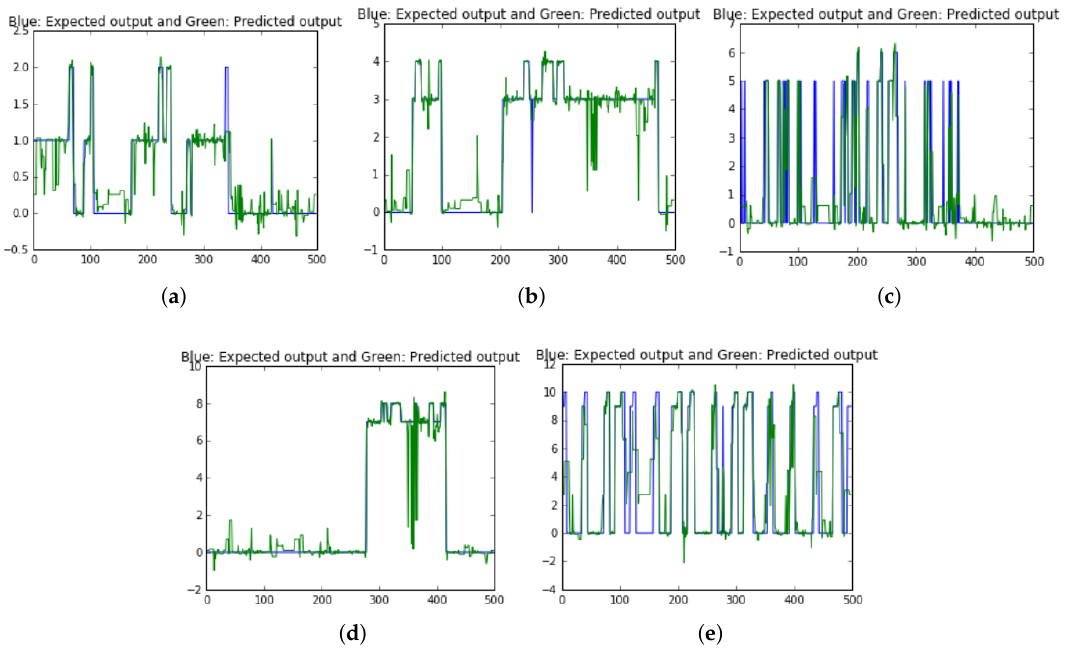
Figure 20. Classification results of LSTM model on 5 appliances data selected in AMPds2: ( a ) Master and South Bedroom; ( b ) Basement Plugs and Lights appliance; ( c ) Instant Hot Water Unit appliance; ( d ) Entertainment: TV, PVR, AMP appliance; ( e ) Kitchen Fridge